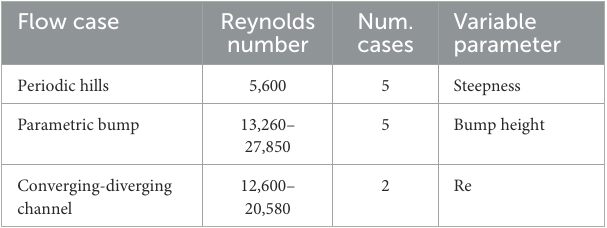
TABLE 1 Different mean flow cases extracted from the McConkey et al. (2021) dataset with their corresponding Reynolds numbers, number of cases, and variable